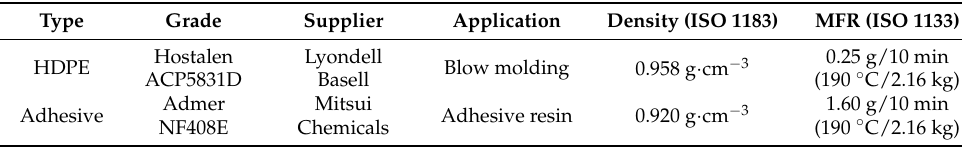
Table 1. Supplier, main application, and properties of the materials